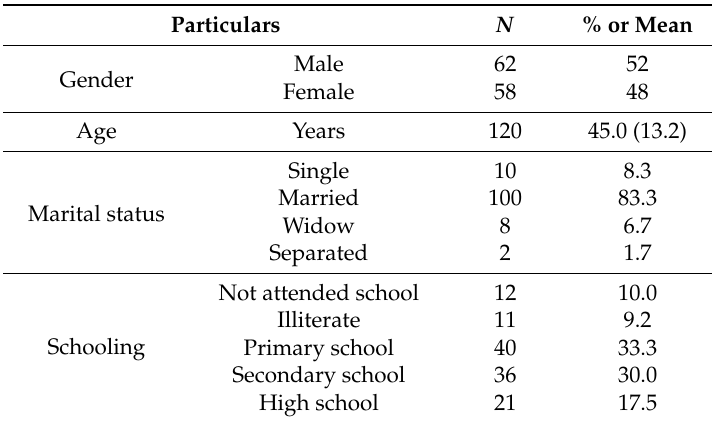
Table 2. Respondents’